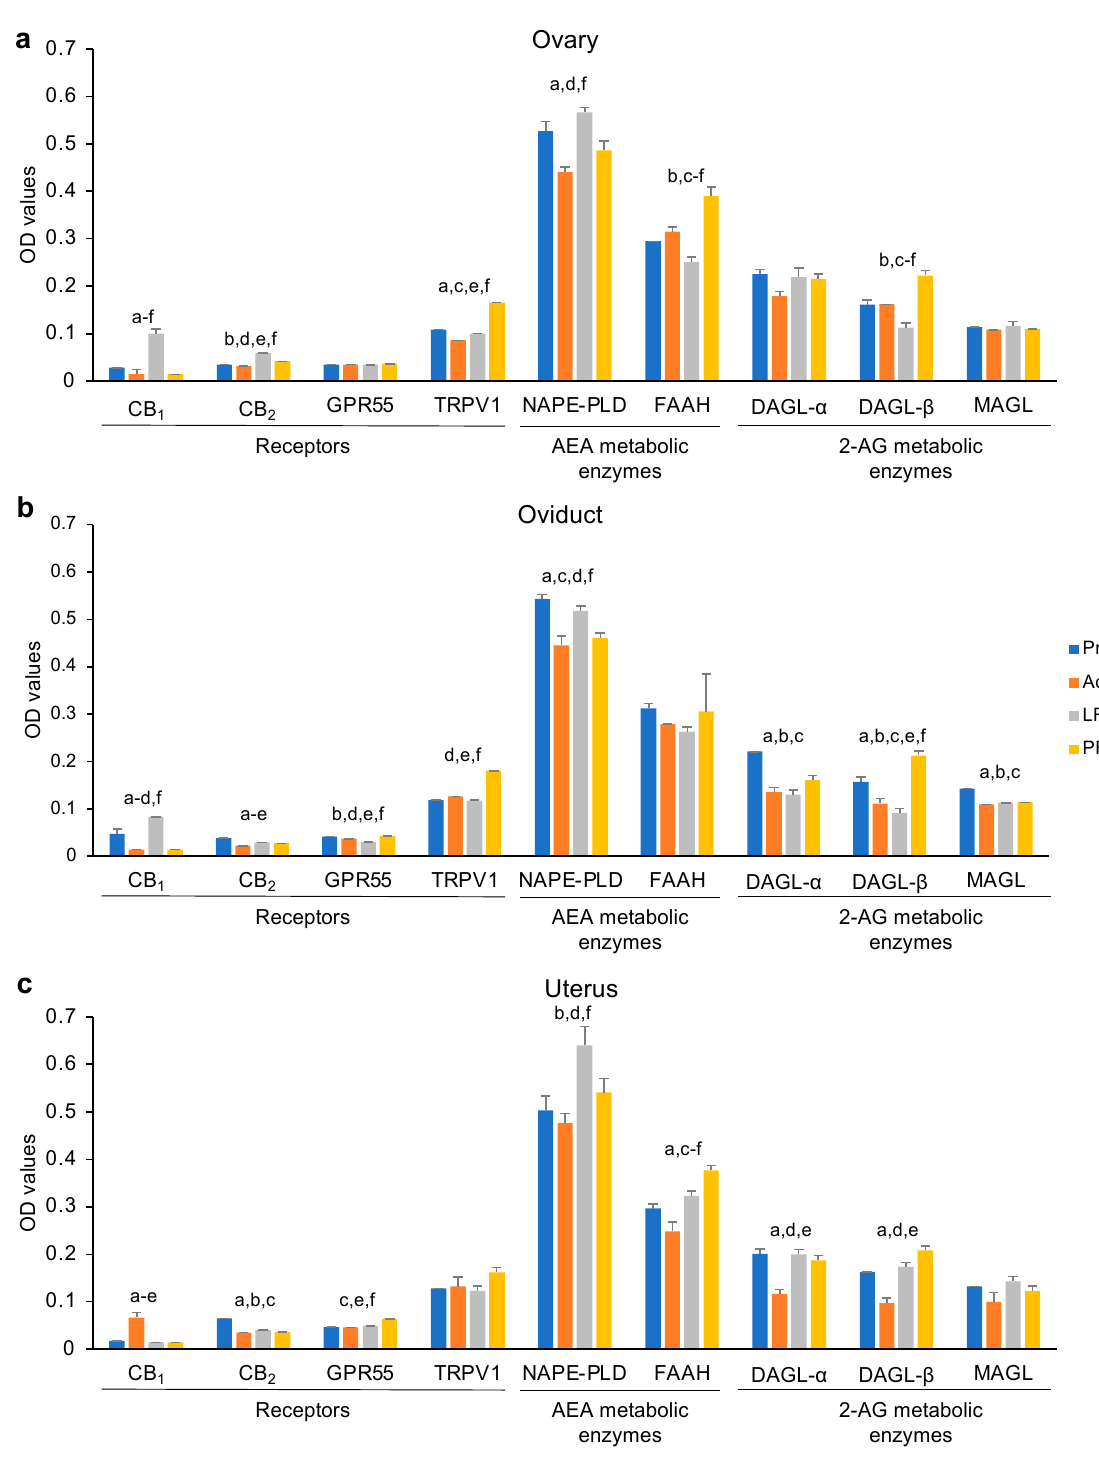
Figure 1. Expression of ECS components in female mouse reproductive tract during aging . Protein expression levels of ECS receptors (CB 1 , CB 2 , GPR55, TRPV1), AEA metabolic enzymes (NAPE-PLD, FAAH), and 2-AG metabolic enzymes (DAGL- α , DAGL- β , MAGL) detected in ovaries ( a ), oviducts ( b ), and uteri ( c ) collected from prepubertal (PrP), adult (Ad), late reproductive (LR), and post-reproductive (PR) mice. Results of three independent experiments expressed as mean OD values ± standard error of the mean (SEM). Letters indicate statistical significance ( p < 0.05) as follows: a: PrP vs. Ad, b: PrP vs. LR; c: PrP vs. PR; d: Ad vs. LR; e: Ad vs. PR; f: LR vs. PR. For more detailed information, please refer to Table S1 in the Supplementary